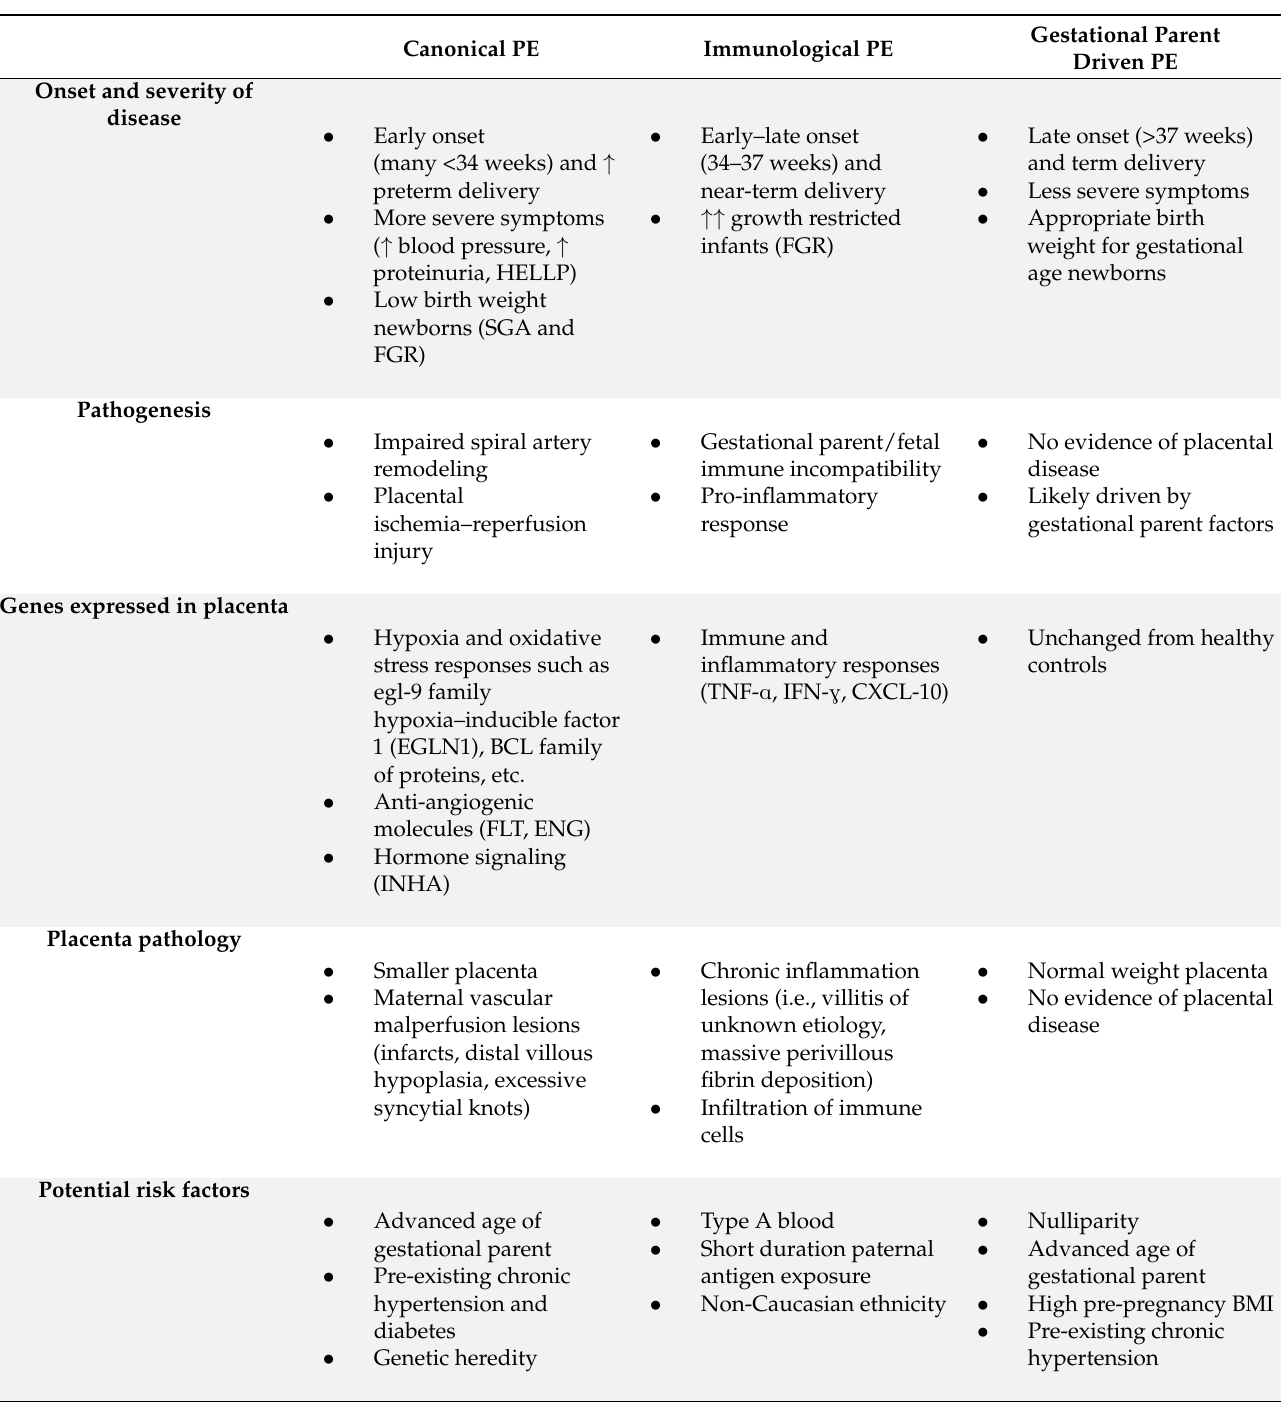
Table 2. Overview of clinical features and mechanistic pathways involved in the pathophysiology of distinct PE